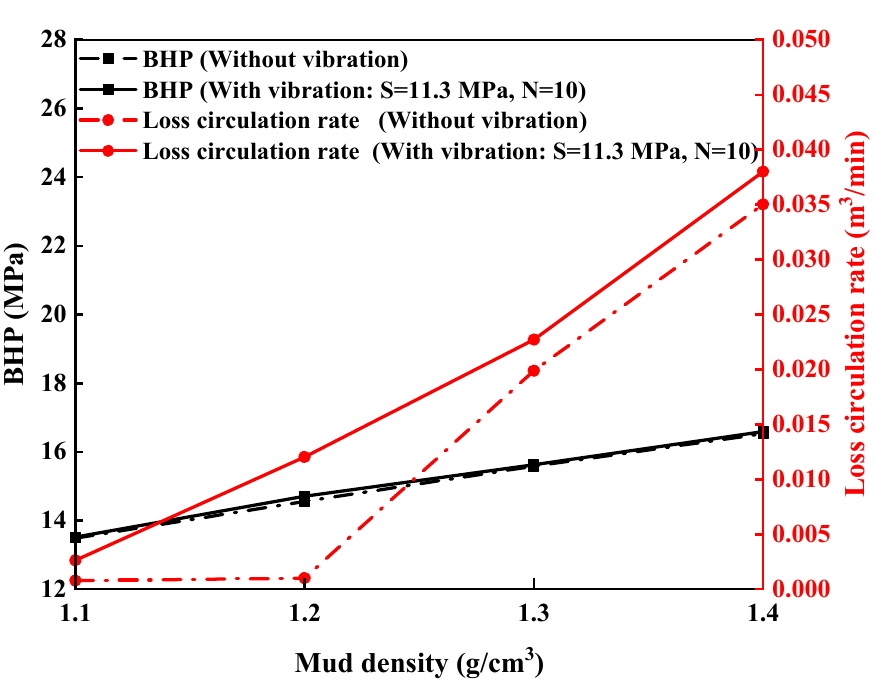
Figure 13. Effect of mud density on loss circulation rate and BHP with and without vibration cyclic loads.